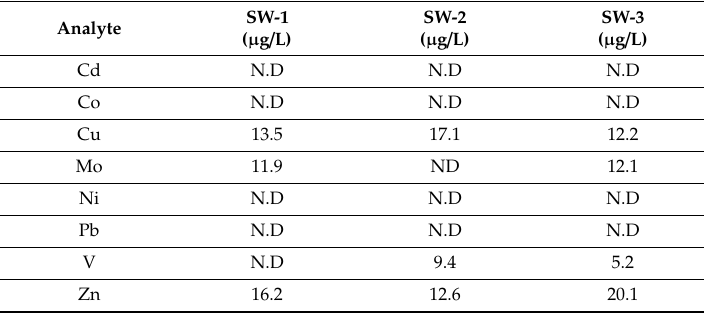
Table 4. Analysis of seawater samples using